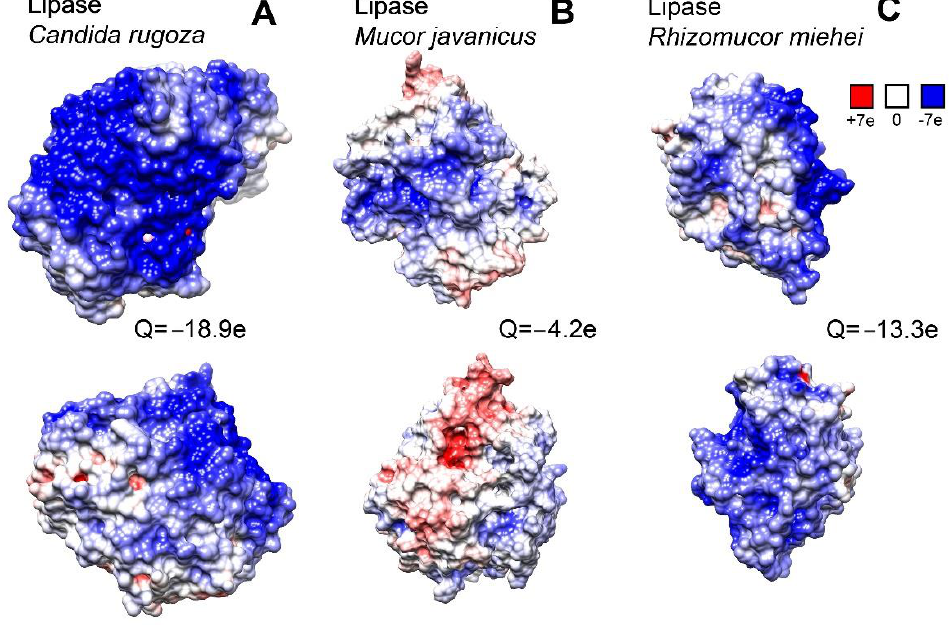
Figure 2. The surface charge simulation of lipase from Candida ( A ), lipase from Mucor javanicus ( B ), and lipase from Rhizomucor miehei ( C ). For every protein, the view of opposite surface is shown above and below.